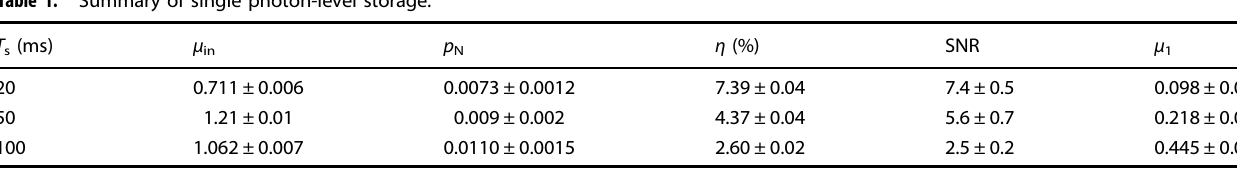
Table 1. Summary of single photon-level storage.